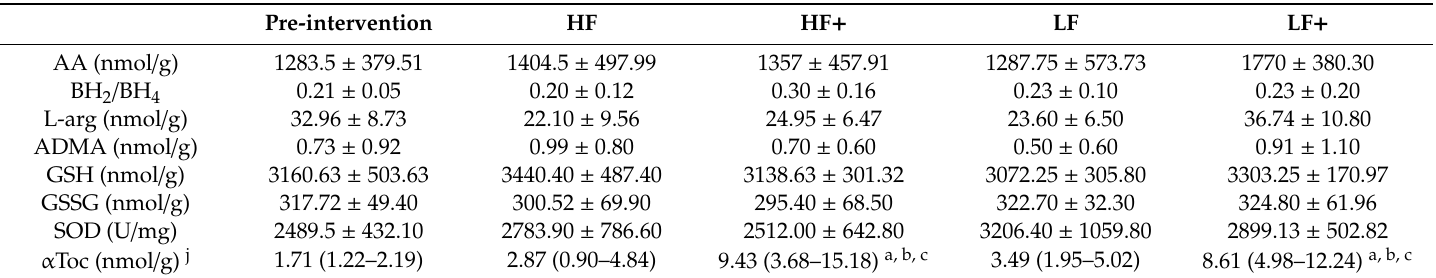
Table 5. Liver status, oxidative stress markers. Pre-intervention and Week